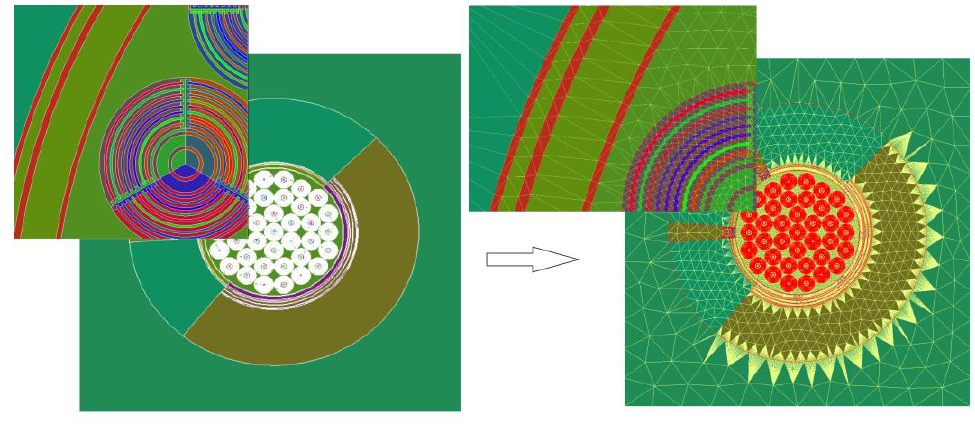
Figure 7. Geometry and mesh for the MINARET-S